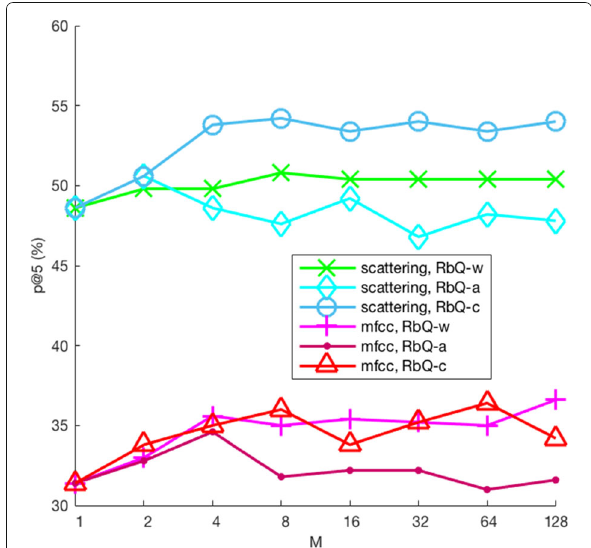
Fig. 7 Acoustic scene similarity retrieval in the DCASE 2013 private dataset: precision at rank 5 ( p @5) obtained for different methods as a function of the number of clusters